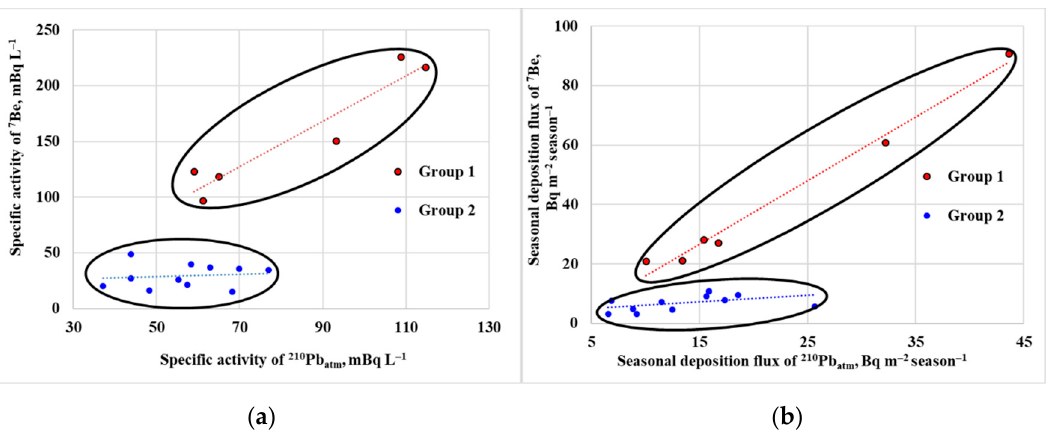
Figure 13. Specific activities ( a ) and seasonal deposition fluxes ( b ) of 210 Pb atm and 7 Be in the coarse ‐ grained Fraction 1 (>3 μ m) of suspended matter in snow water.